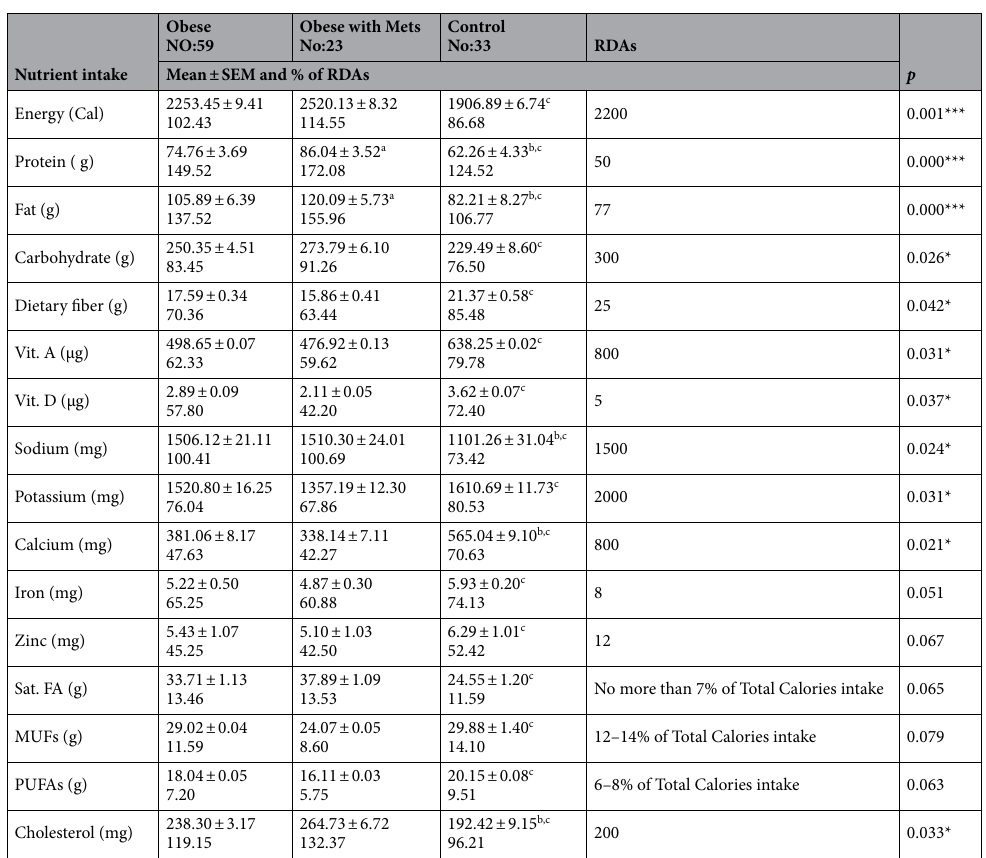
Table 4. Mean ± SE and % of the RDA of nutrients intake of the studied women. Significant between groups * p ≤ 0.05, ** p ≤ 0.01, *** p ≤ 0.001. a Obese without MetS V Obese with Mets, b Obese without MetS V Control, c Obese with Mets V Control.